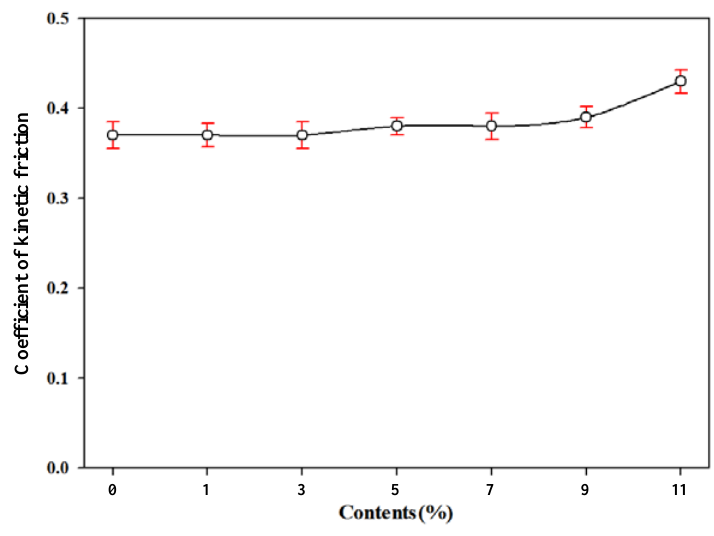
Figure 7. Coefficient of kinetic friction of polyester thermoplastic film with various contents of thermally expandable microcapsules.